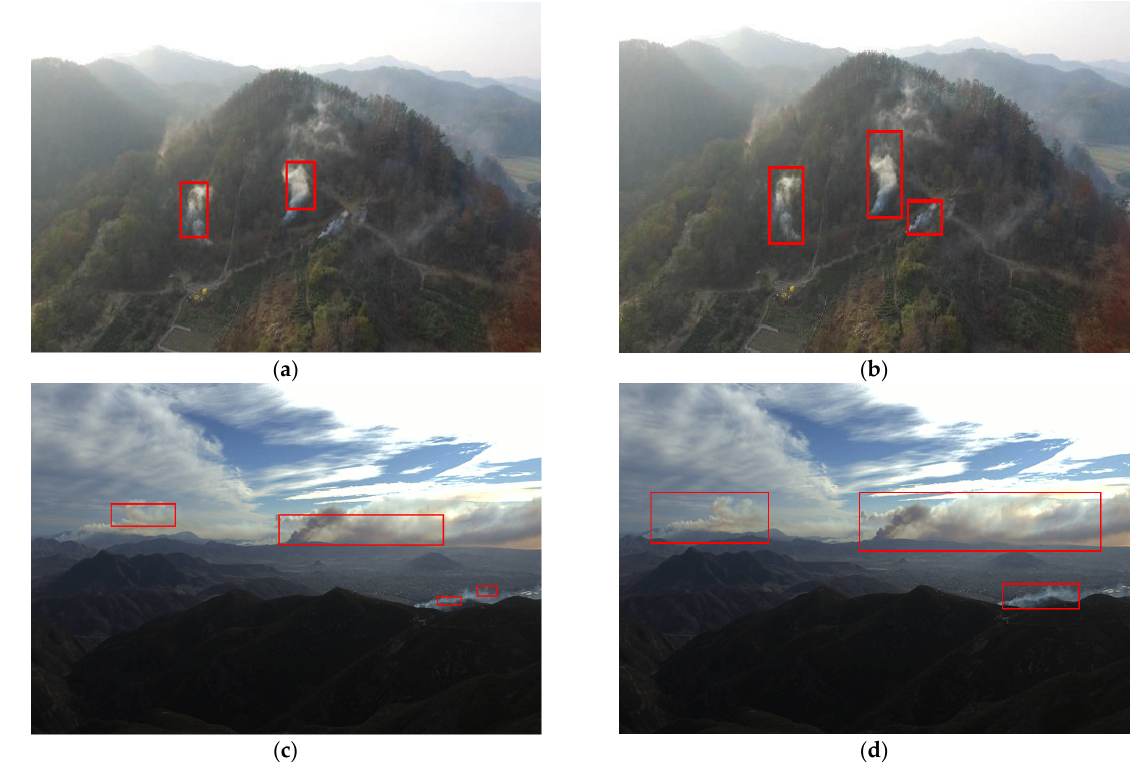
Figure 6. Different detection samples before and after using iterative bounding box combination method. ( a , c ) Original detection results; ( a ) contains one missed detection; ( c ) contains one false detection. ( b , d ) The updated detection results where bounding boxes are generated by our method. The bounding boxes can cover the whole smoke accurately in both ( b , d ).